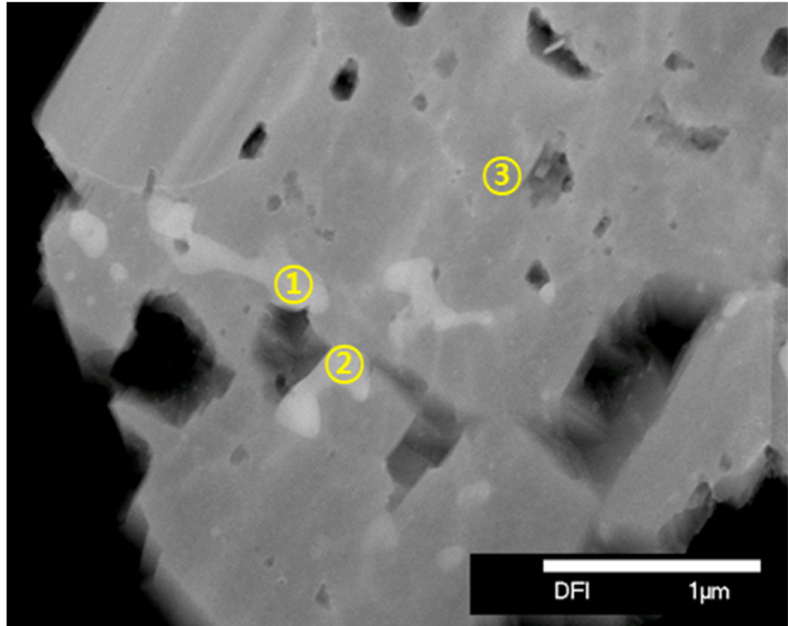
Figure 5. TEM image of the matrix at a reaction time at 3 h. Table 3. TEM-EDS results of reaction zone after 3 h.